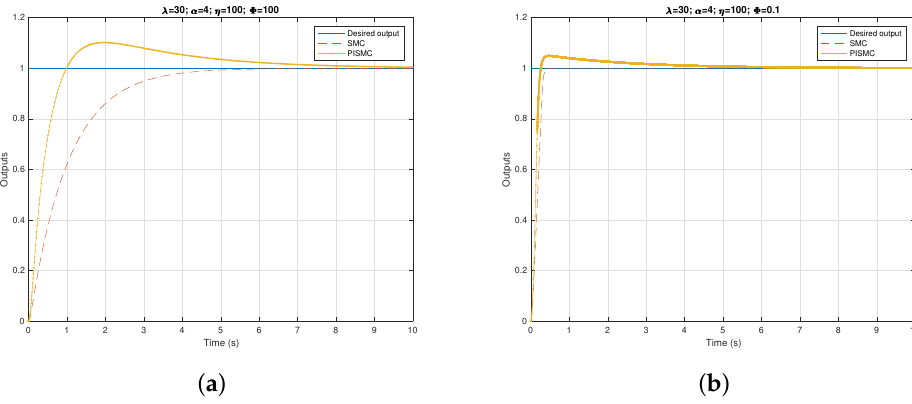
Figure 2. Comparison of parameter effectiveness. ( a ) Φ = 100; ( b ) Φ = 0.1.